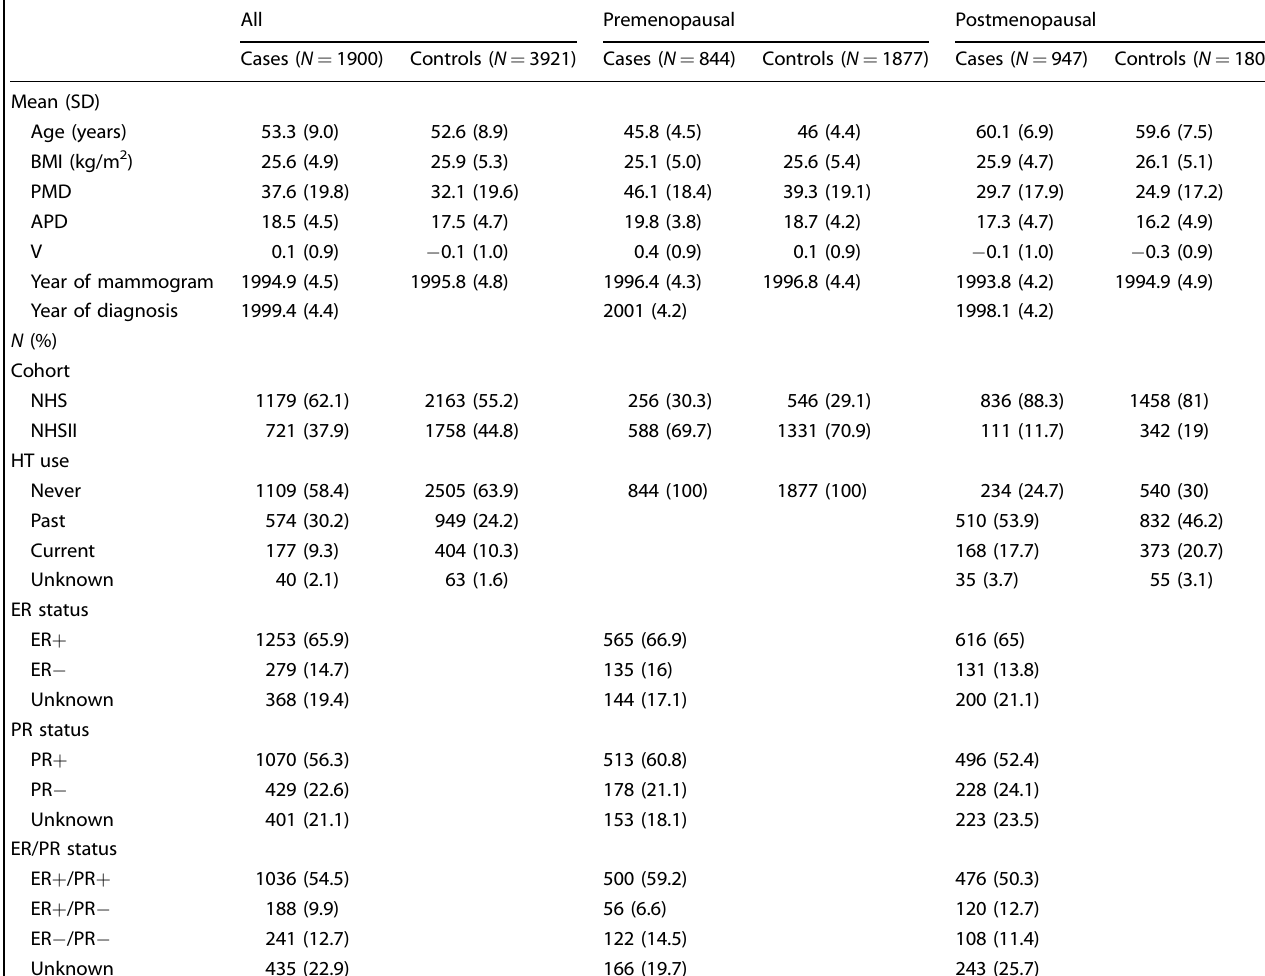
Table 1. Participant characteristics at time of mammogram for breast cancer cases and controls by menopausal status.